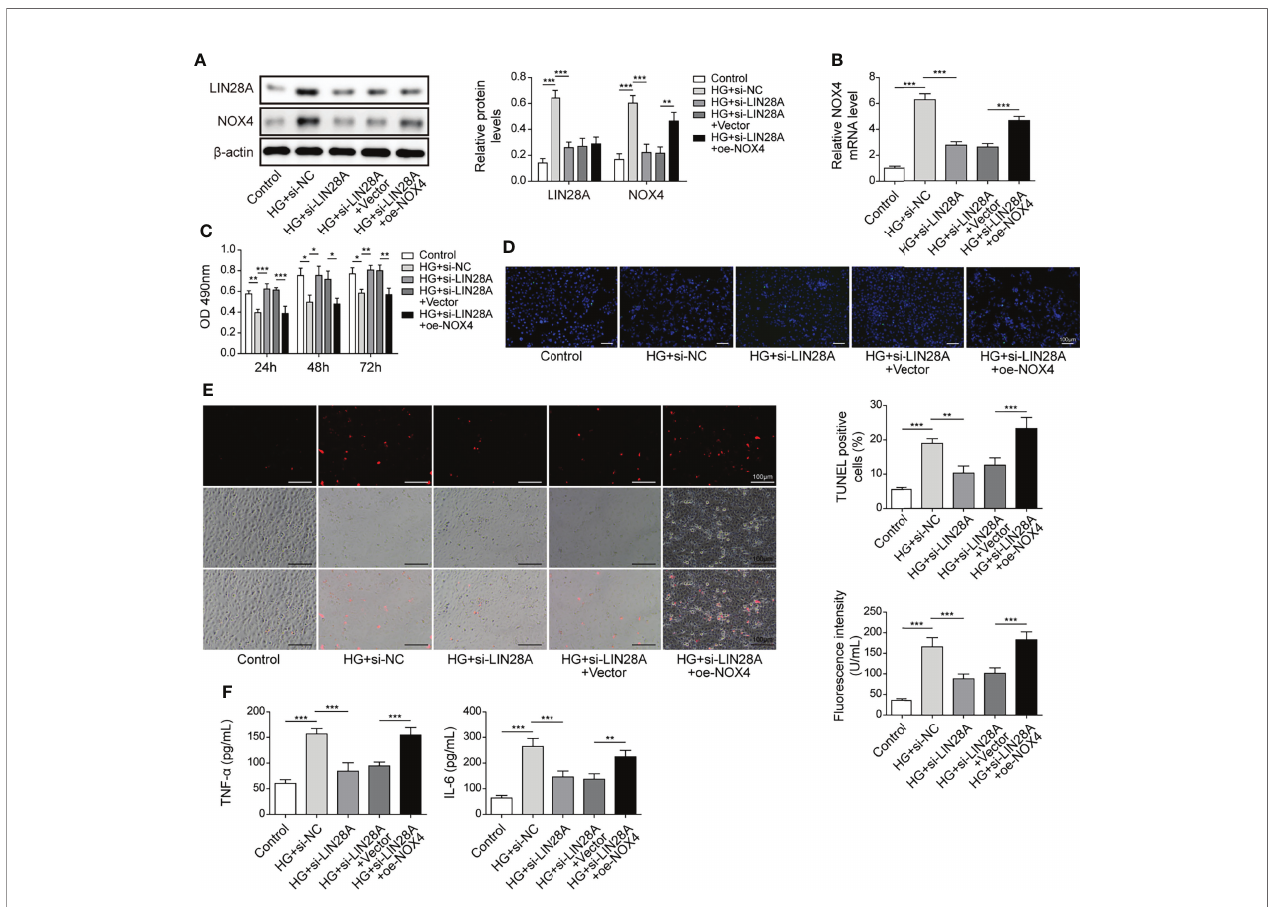
FIGURE 7 | LIN28A aggravated HG-induced injury by targeting Nox4. HK-2 cells were transfected with si-NC, si-LIN28A, si-LIN28A + vector or si-LIN28A + oe- Nox4 and subsequently treated with HG for 48 h (A) Western blotting analysis of LIN28A and Nox4 (n=4). (B) qRT-PCR analysis of Nox4 (n=4). (C) Cell viability was examined by MTT assays (n=4). (D) TUNEL staining (TUNEL, green. Scale bar=100 µM) were examined. (E) Cellular ROS levels were examined by a fl uorometric ROS sensor (red, n=4. Scale bar=100 µM). (F) Secretion of TNF- a and IL-6 into culture supernatants (n=4). * P < 0.05, ** P < 0.01 and *** P <